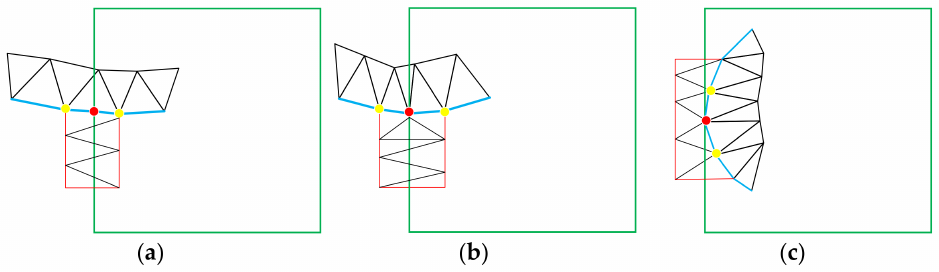
Figure 7. Topologically closed triangulation: ( a ) case 1; ( b ) case 2; ( c ) case 3. To ensure the accuracy of the hole fitting surface in a partitioning cell, appropriate height values should be assigned to network-constructing points near the grid